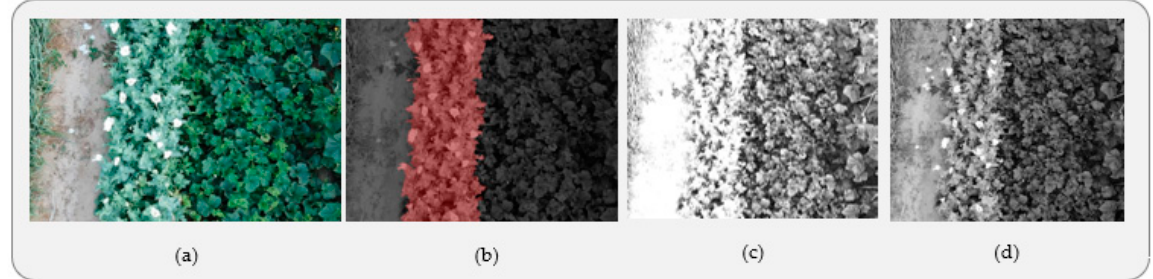
Figure 2. ( a ) The original poppy image, ( b ) ground truth and ( c , d ) the augmented image.